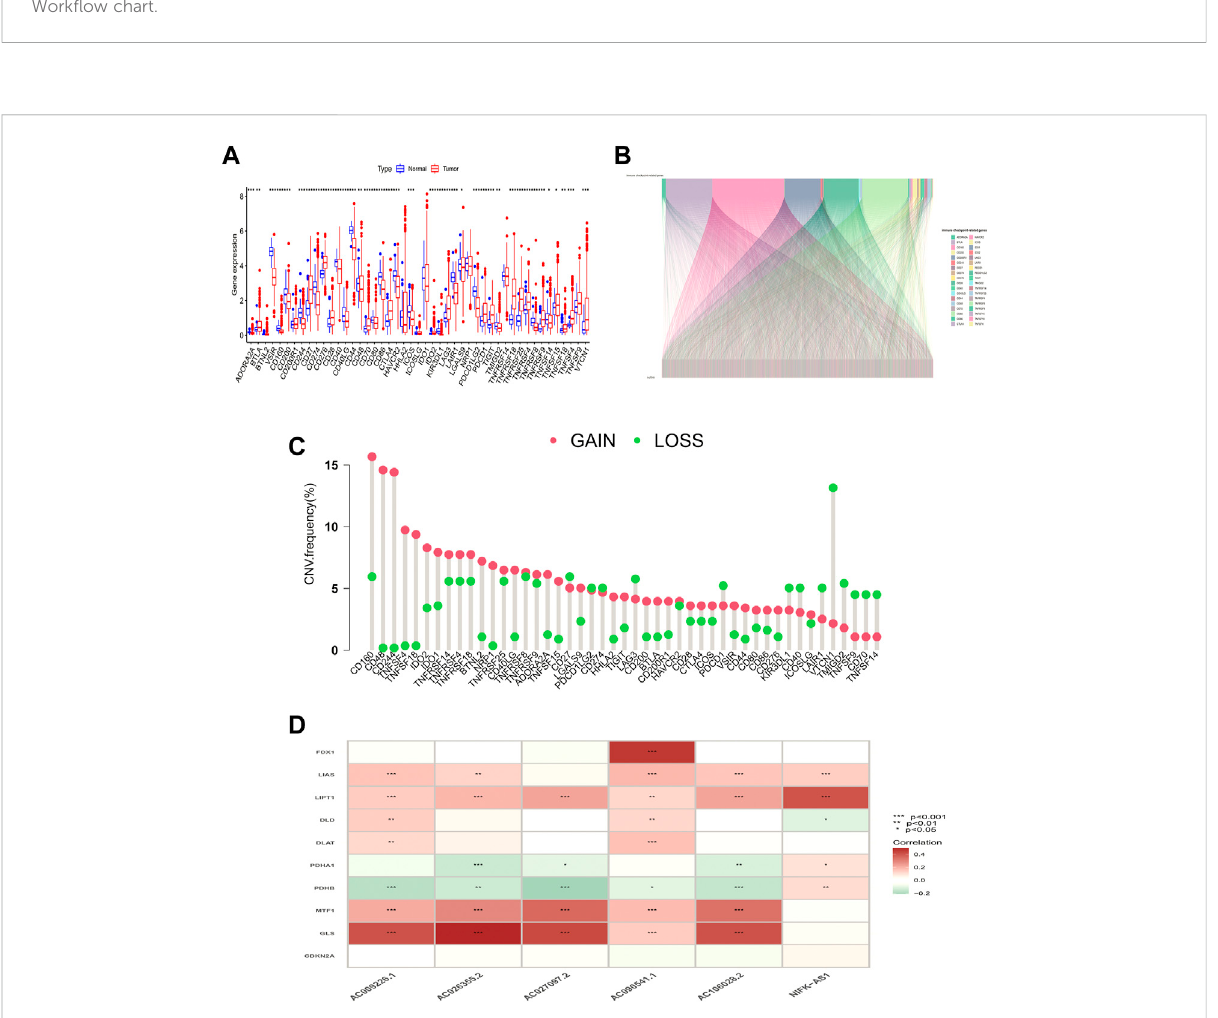
FIGURE 2 Genetic and expression variation of theMRDEGs in LUAD patients. (A) ICP-related gene expression pro fi le. (B) Sankey relation diagram for ICP- related genes and lncRNAs. (C) The CNV frequency of 47 ICP genes in the LUAD cohort. (D) Heatmap for the correlations between randomly ICP- related genes and